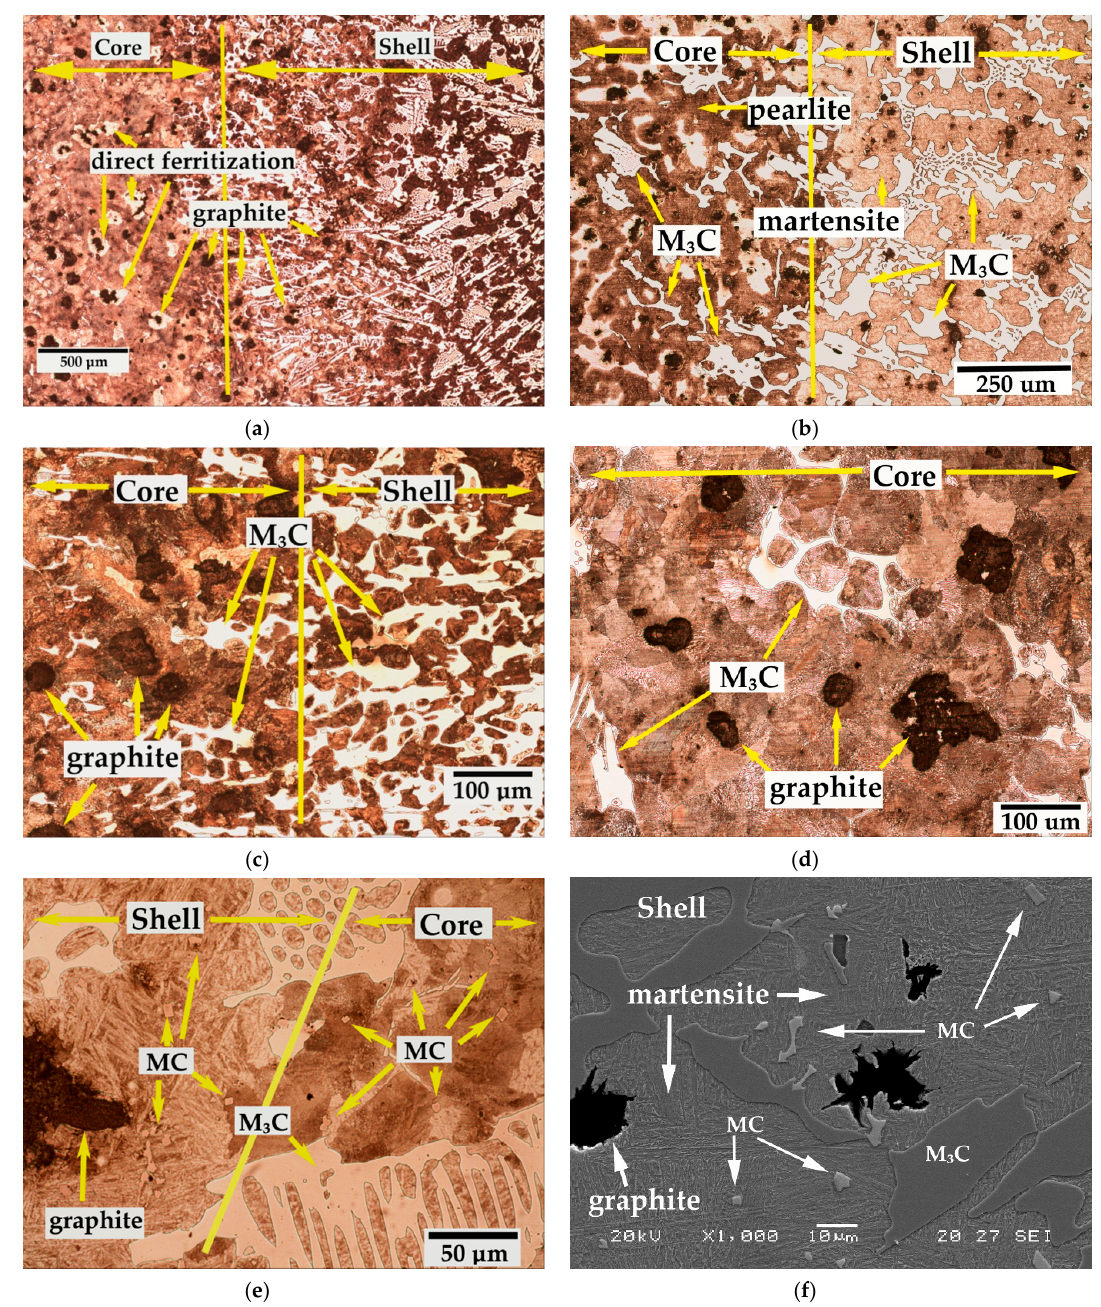
Figure 1. Microstructure of the shell-core bonding region. ( a ) Bonding region corresponding to experiment 2. Ferrite regions can be observed around the spheroidal graphite. Micrograph obtained by optical microscopy. × 50 magnifications, ( b ) Bonding region corresponding to experiment 3. Martensite is the matrix phase in the part of the bond corresponding to the shell and pearlite is the constituent matrix of the bond in the part of the core. Micrograph obtained by optical microscopy. × 100 magnifications, ( c ) Bonding region corresponding to experiment 2. The penetration of M 3 C carbides towards the core is observed. Micrograph obtained by optical microscopy. × 200 magnifications, ( d ) Bonding region corresponding to experiment 8. M 3 C carbides are observed in the part of the core adjacent to the bond. Micrograph obtained by optical microscopy. × 200 magnifications, ( e ) Bonding region corresponding to experiment 1. MC (NbC) carbides are observed in the core. Micrograph obtained by optical microscopy. × 500 magnifications, ( f ) Bonding region corresponding to experiment 7. Presence of mixed carbides in a martensitic matrix. Micrograph obtained by scanning electron microscopy. × 1000